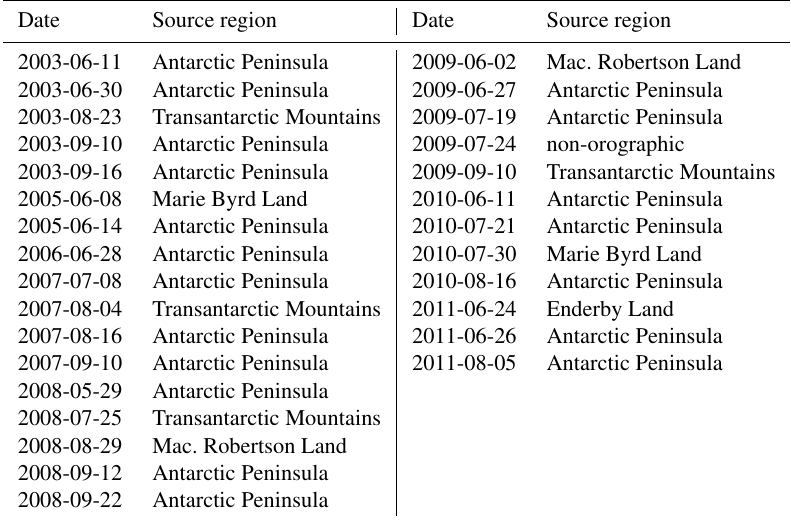
Table 4. Southern Hemisphere gravity-wave-induced PSC formation